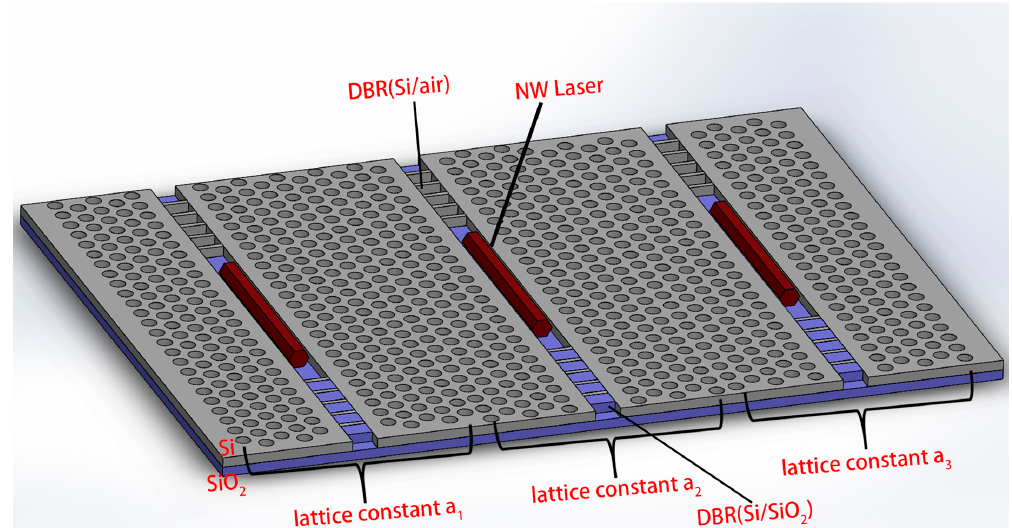
Figure 1. The schematic diagram of the multi-wavelength NW lasers combined with a PhC microcavity and asymmetric DBRs on the SOI chip.